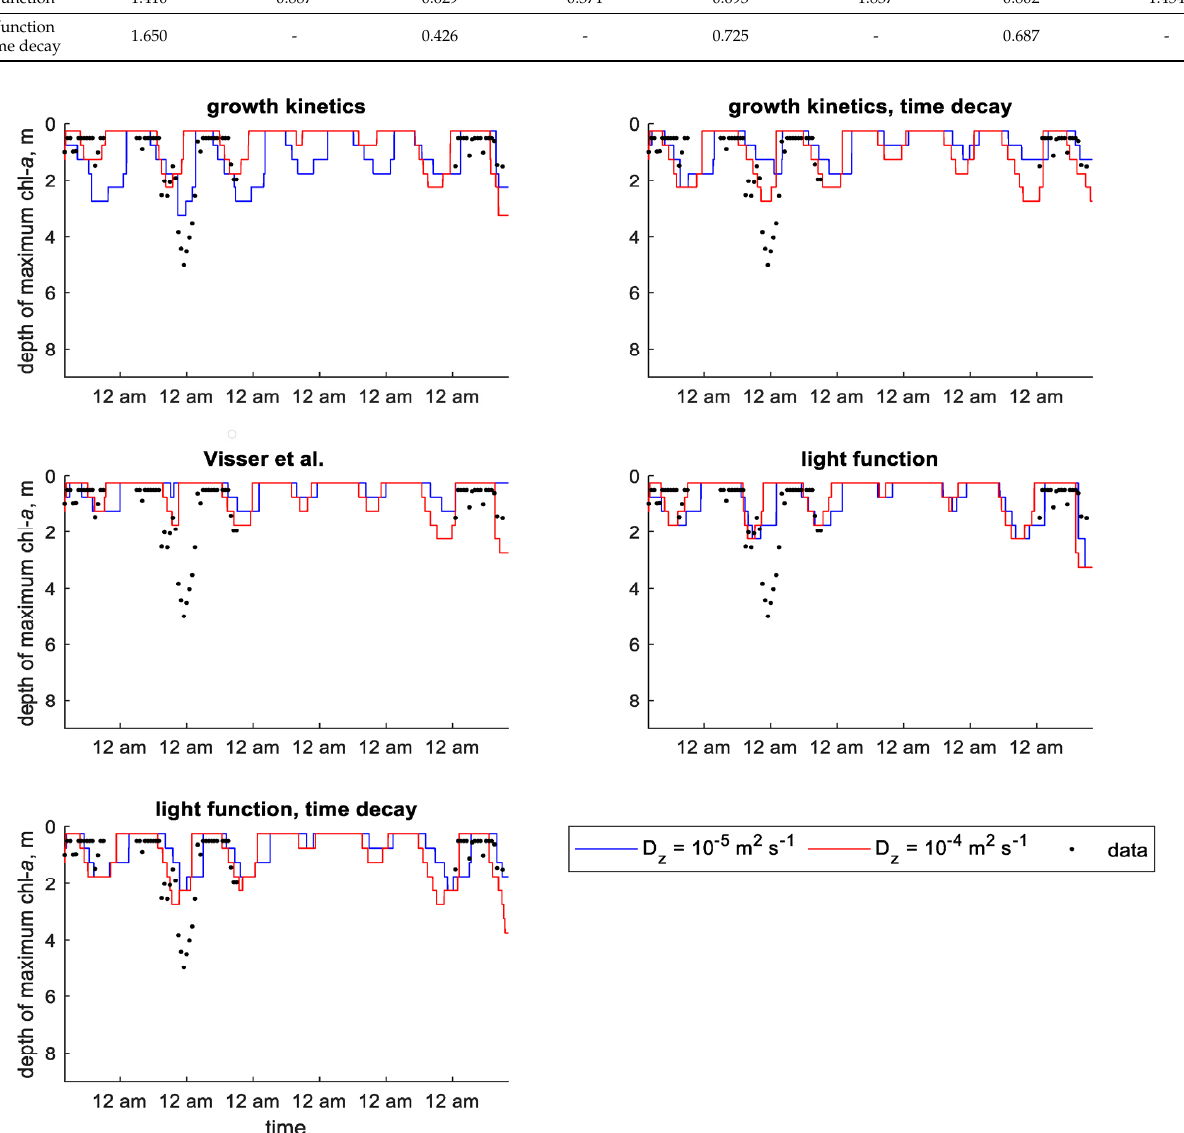
Figure 7. Time series of observed and predicted depth of maximum chlorophyll a concentration in Xiangxi Bay using dynamic velocity models (continuum)